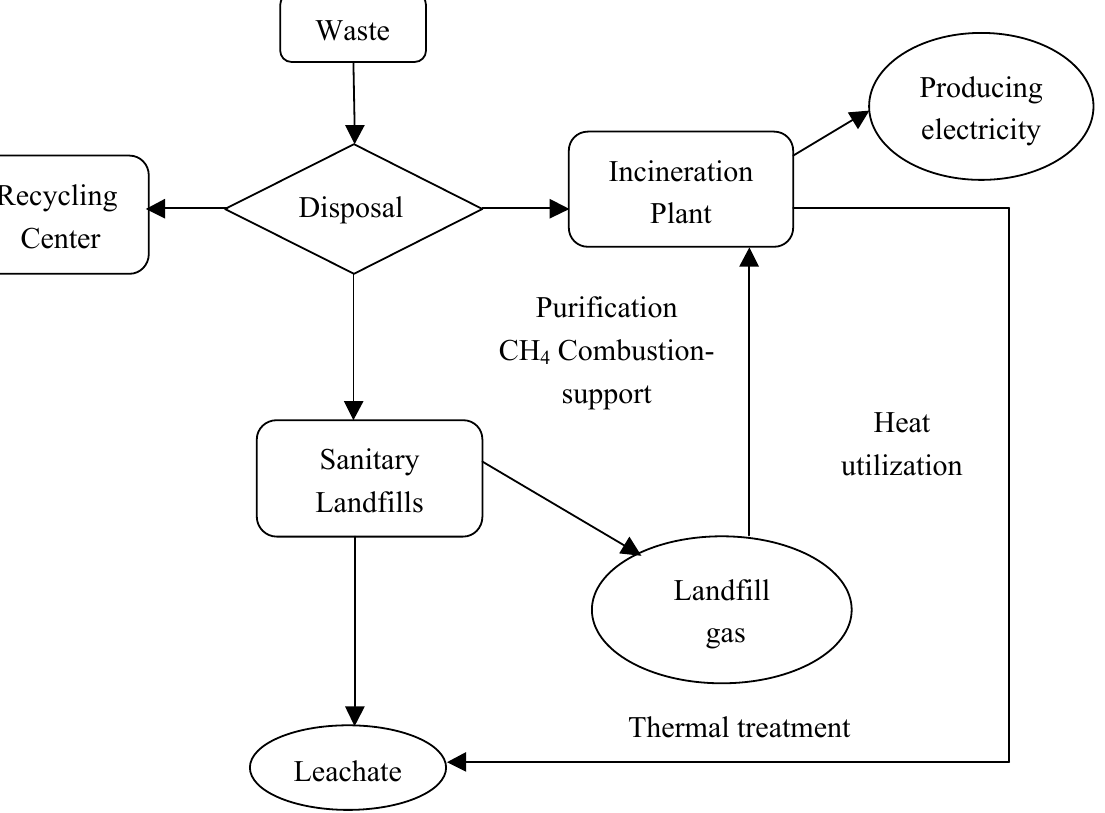
Figure 1. Conceptual alternative treatment system for landfill gas and leachate